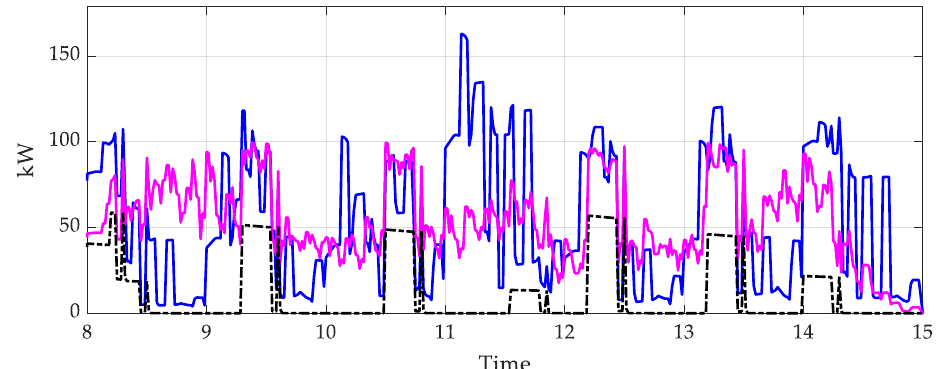
Figure 32. PWL representations of the optimal load profiles (magenta—aggregated profile based on the shifting configuration resulted from the PWL approximation, blue—aggregated profile based on the shifting configuration resulted from the staircase approximation, black—non-shiftable loads).